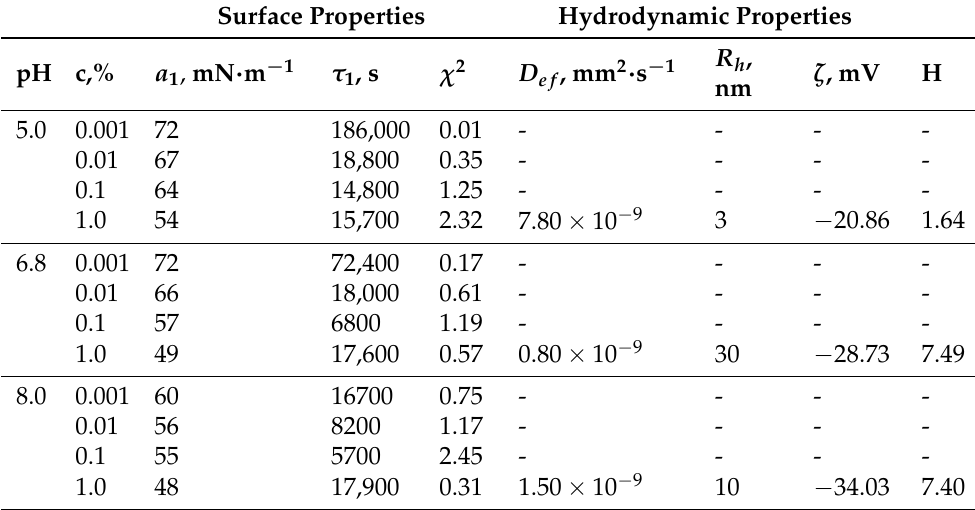
Figure 1. SDS-PAGE profiles of Vicia faba L. under reduction conditions. Lane: A-protein markers; B- Vicia faba L. protein isolate. Table 1. Surface, hydrodynamics parameters, and hydrophobicity of Vicia faba L. protein isolate